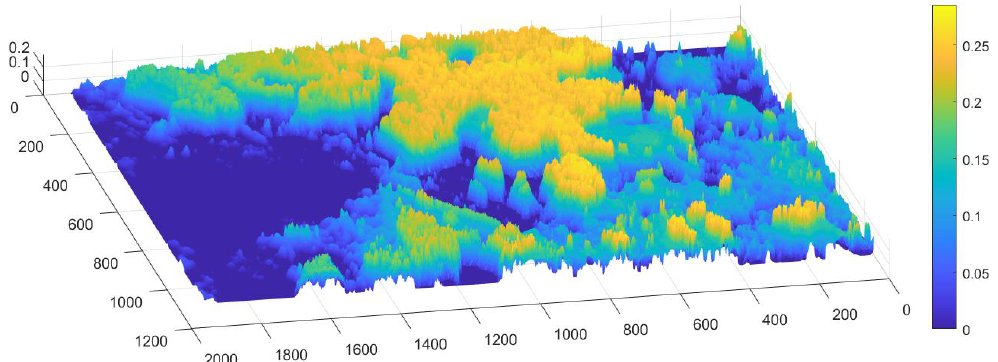
Figure 11. Pseudo-3D surface of the sample (P3DS). It shows the micro morphology of the surface. Taking in accounts the non-homogeneous point by point homogeneity of the reflected light from the sample it shows some interesting features. The color bar represents the Euclidean distance (d) expressed in mm; on the x and y axes, there are pixel numbers. The 3D reconstruction is specular to the original image. The x and y axes are in pixels.